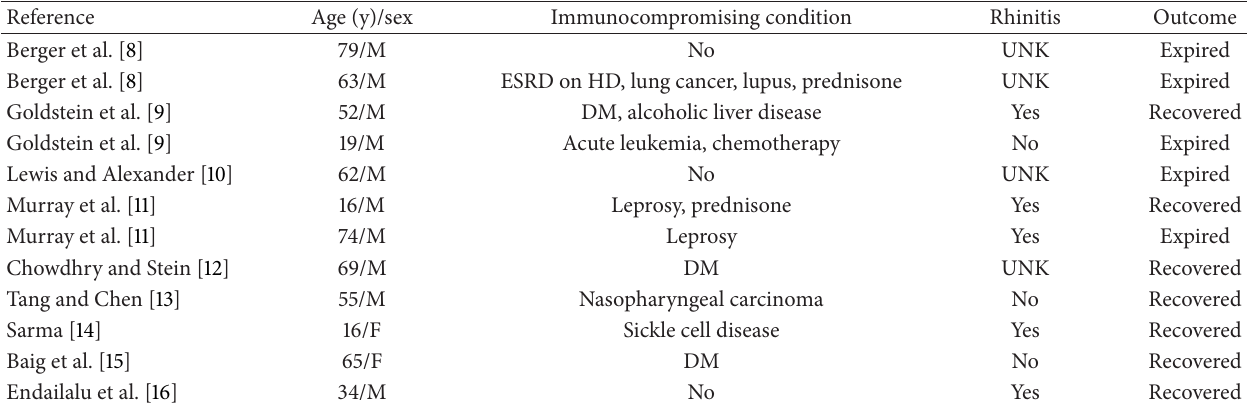
Table 1: Clinical characteristics of K. ozaenae bacteremia reported